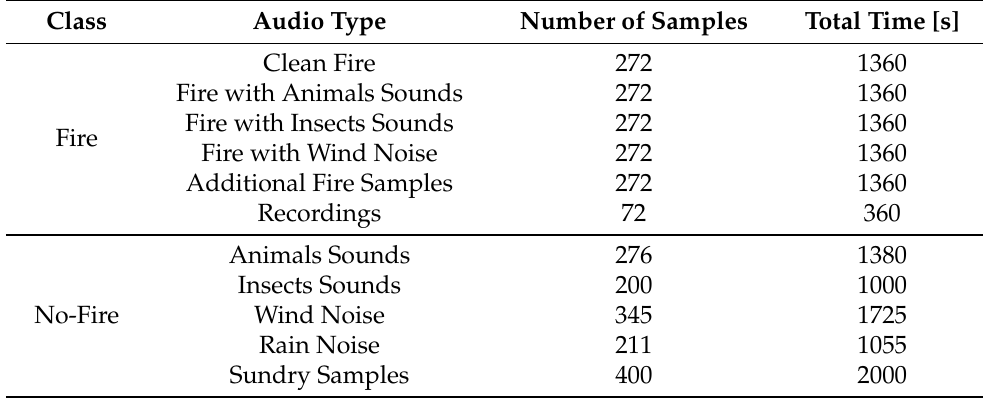
Table 1. Audio dataset description.